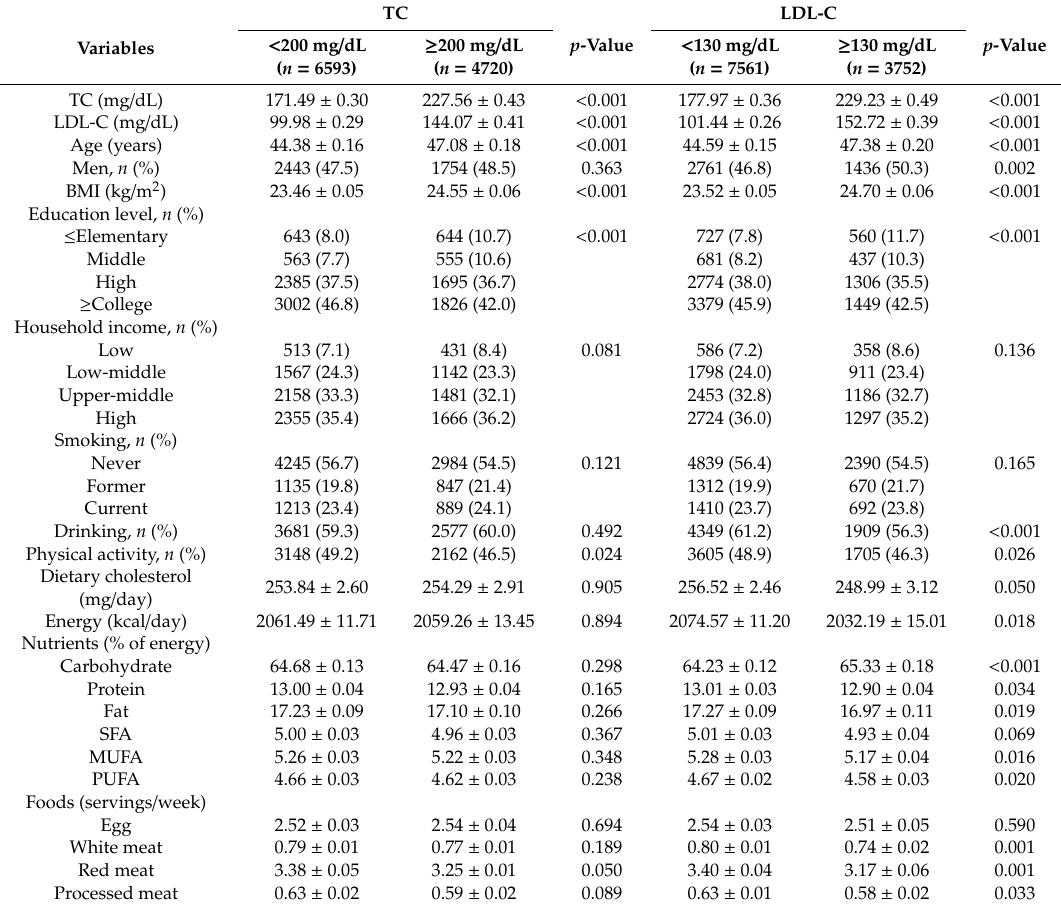
Table 1. Baseline characteristics of participants according to total cholesterol (TC) and low-density lipoprotein-cholesterol (LDL-C) levels a